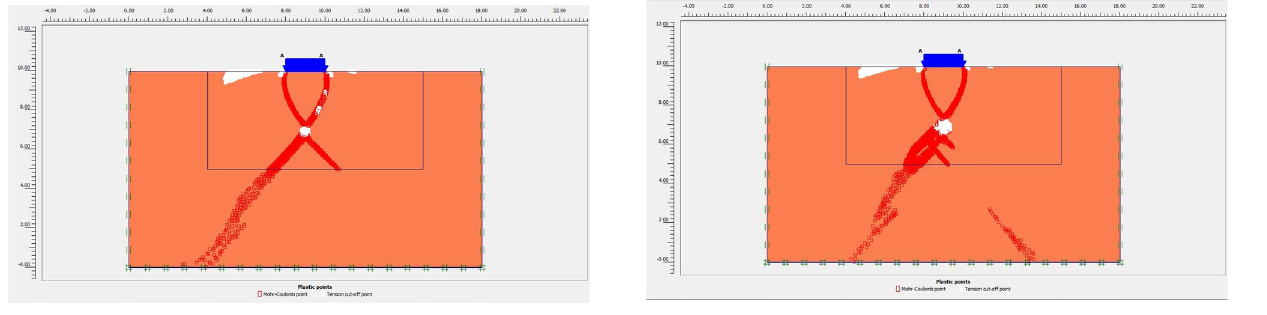
Fig. 27 Plastic points changes for the failed soil with 6% gasoline